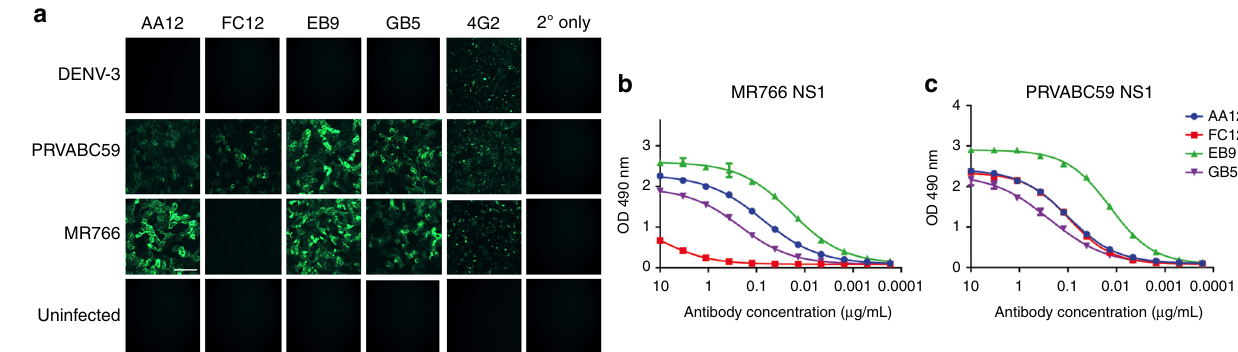
Fig. 1 Human ZIKV speci fi c-antibodies bind to both MR766 and PRVABC59 NS1 proteins. a Vero cells were infected with the indicated viruses at an MOI of 1 for 24 h. The cells were fi xed with 0.5% paraformaldehyde and blocked with 5% non-fat milk. MAbs AA12, FC12, EB9, and GB5 were used at a concentration of 5 μ g per mL and an anti-human antibody conjugated to Alexa Fluor 488 was used as a secondary antibody. The murine pan- fl avivirus mAb 4G2 was used as a positive control and an anti-mouse antibody conjugated to Alexa Fluor 488 was used as a secondary antibody. Cells stained with mAb 4G2 were fi xed and permeabilized using 80% acetone. b , c ELISA assays were performed using recombinant NS1 protein from either MR766 or PRVABC59 viruses to assess the binding activity of mAbs AA12, FC12, EB9, and GB5. ELISAs were performed in duplicates. Data plotted represent mean values and the standard error of the mean (SEM); a non-linear regression line was generated using GraphPad Prism 5. Scale = 100 µ m